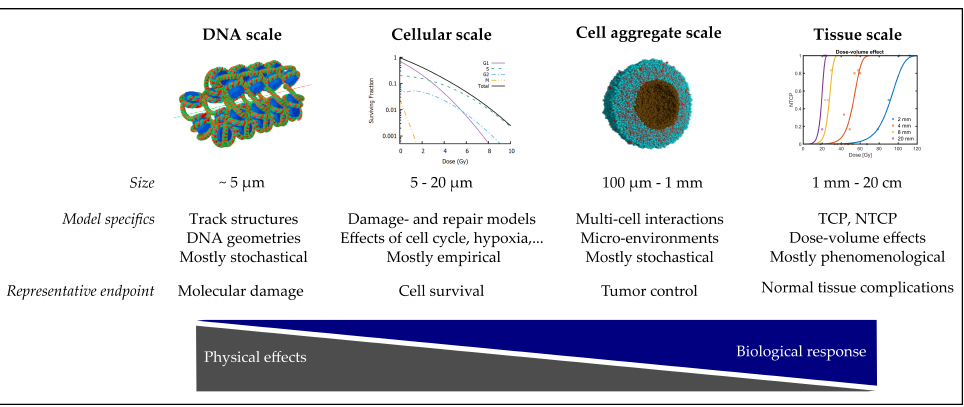
Figure 4. Overview of in silico models for proton radiobiology experiments. Images (left to right): chromatin fiber [280], surviving cell fraction in dependence on the cell cycle phase [281], simulated tumor spheroid 40 min post photon irradiation [70], NTCP model for increasing irradiation volumes (courtesy of